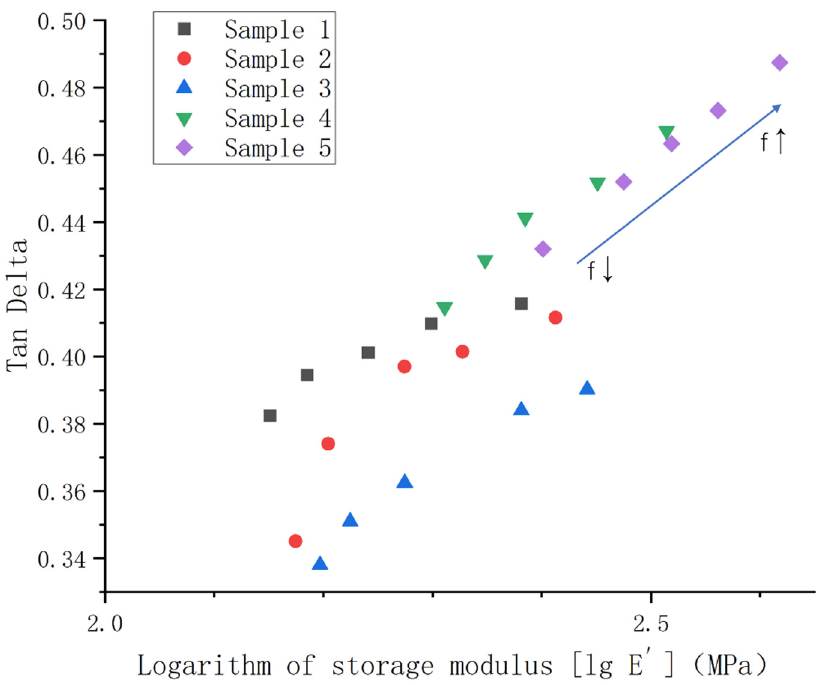
Figure 12. Relationship between the loss factor and storage modulus of samples 1–5 at − 60 °C.